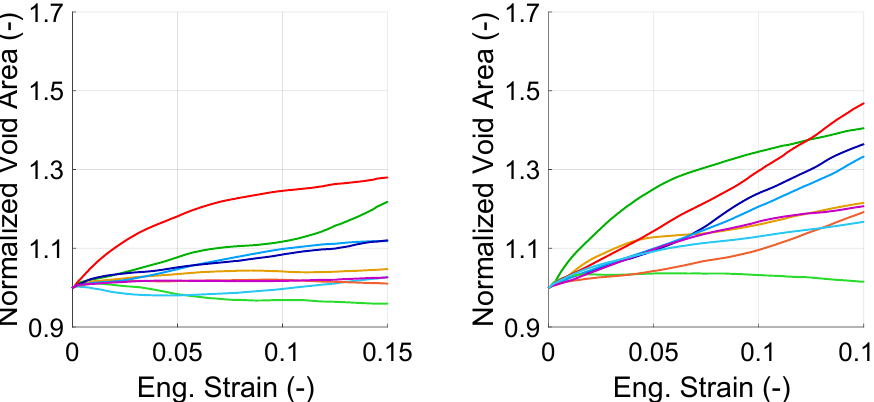
Figure 13. Evolution of the normalized area of individual in-grain voids in banded ( left ) and random ( right ) morphology. Each color represents one void.